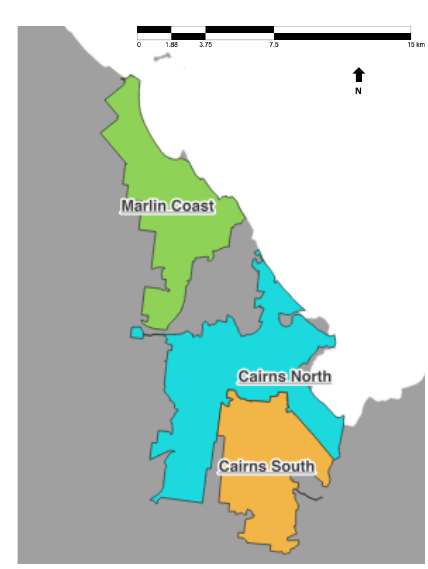
Figure 2. Catchment boundaries of wastewater treatment plants in the Cairns region.